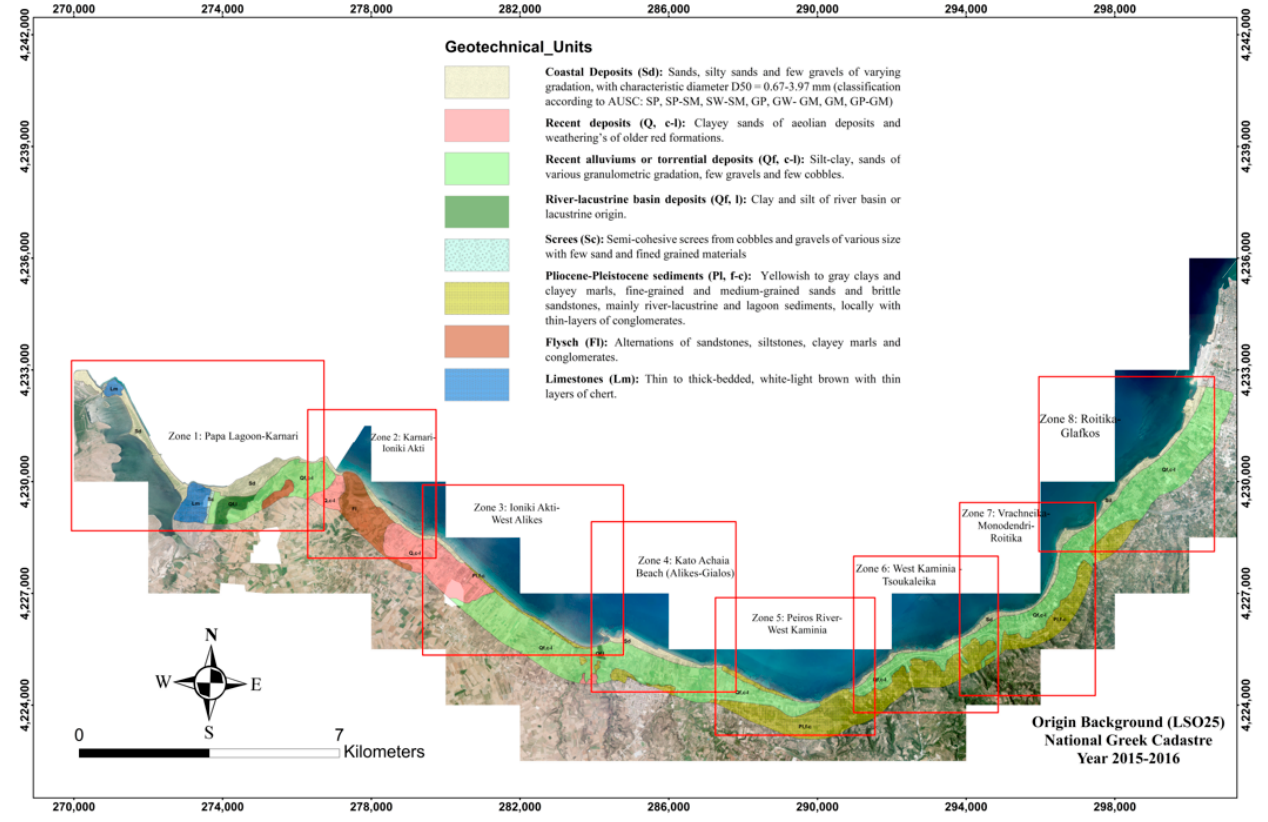
Figure 9. Engineering geological map with geotechnical units of the study area.